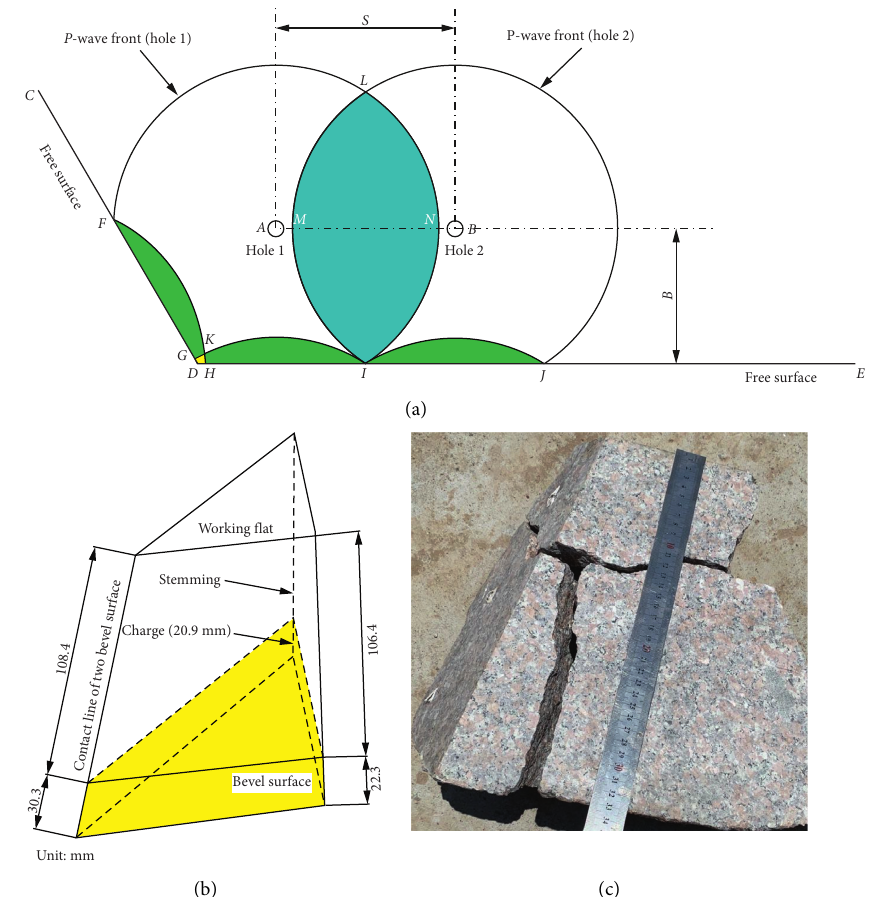
Figure 8: Stress wave distribution and the first crack initiation on the bevel surface in the simultaneous rock blasting: (a) stress wave distribution; (b) a part of double-hole bench model; (c) a part of fragmentation for test